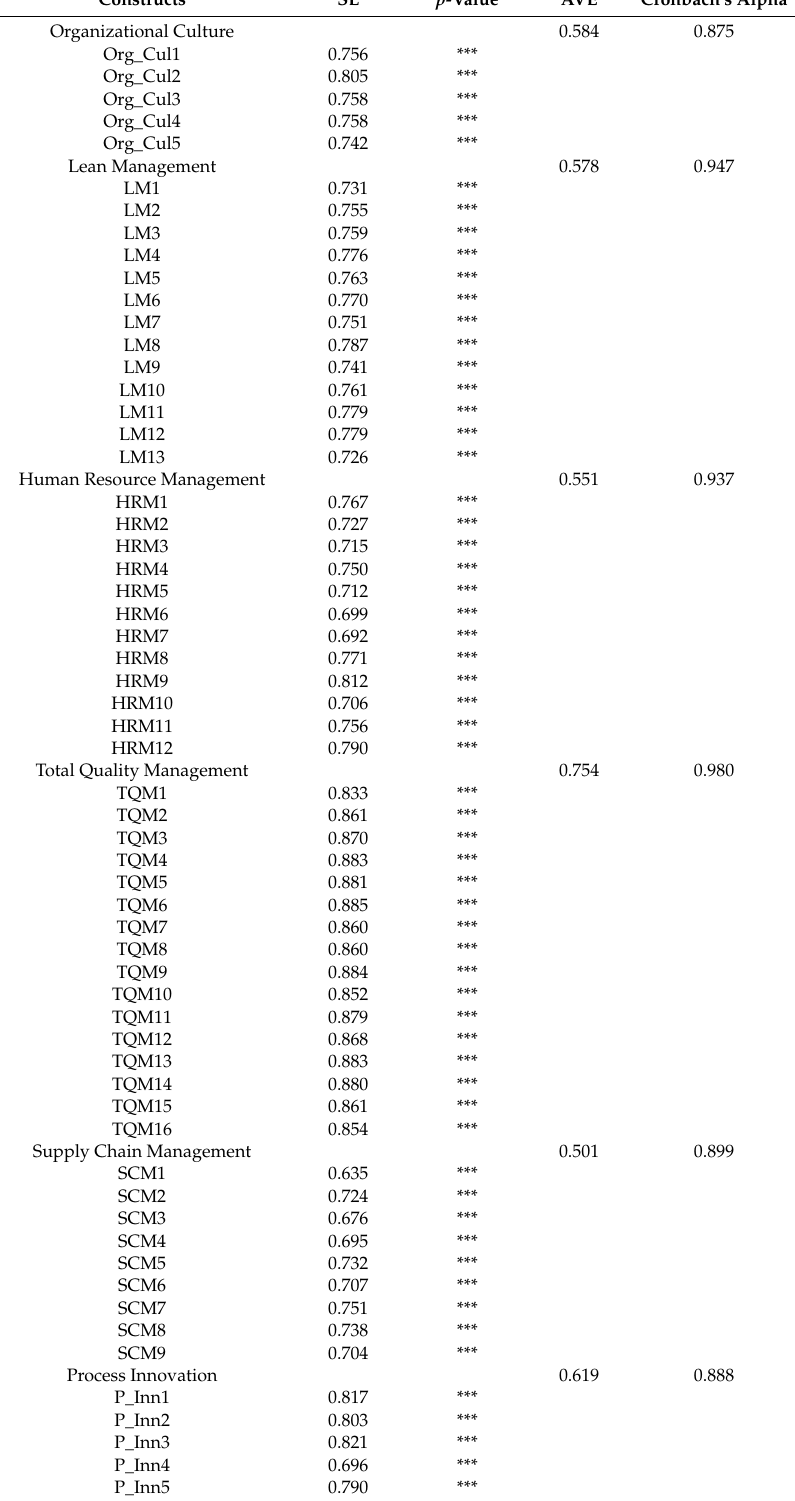
Table A2. Scale validity and